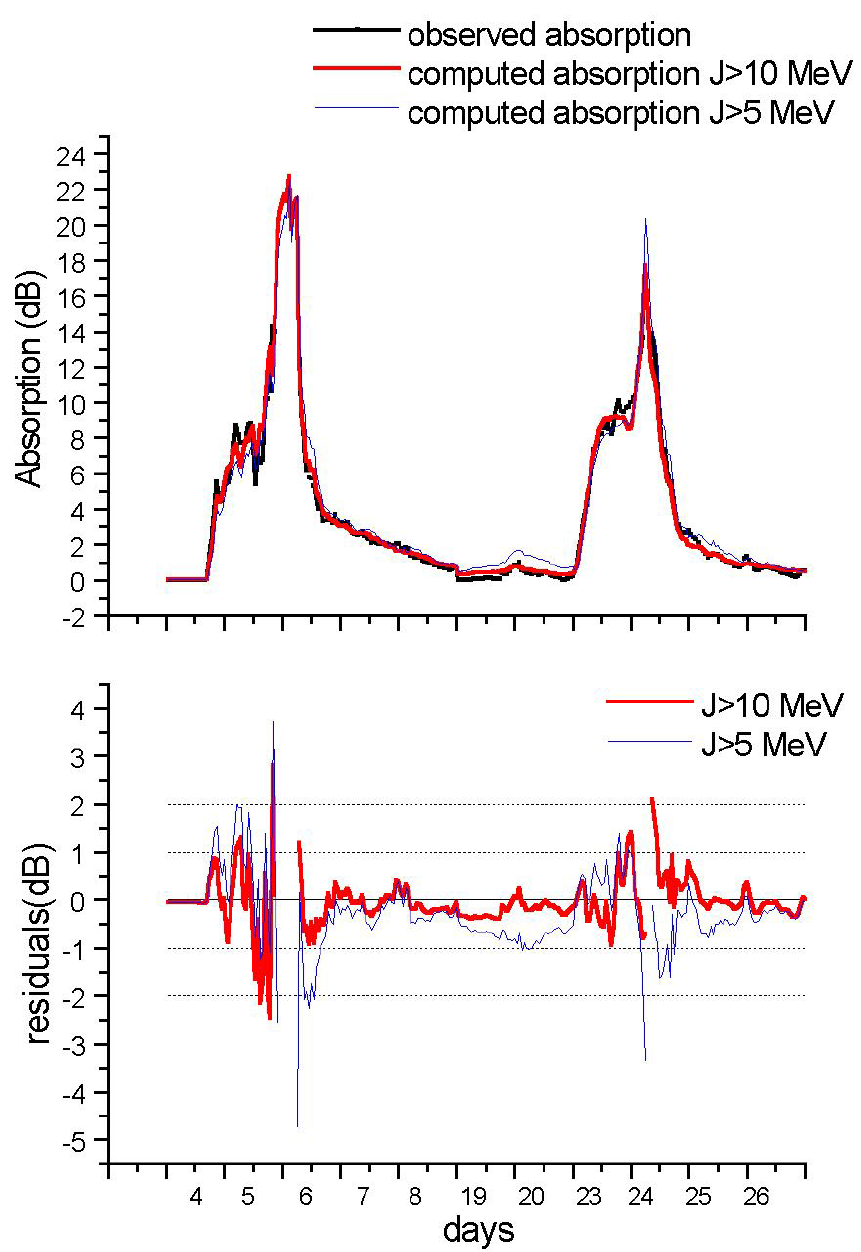
Fig. 11. Hourly means of observed and computed absorption (for J> 5MeV, J> 10MeV) for the three PCA events. Corresponding residuals (observed – calculated absorption) are also